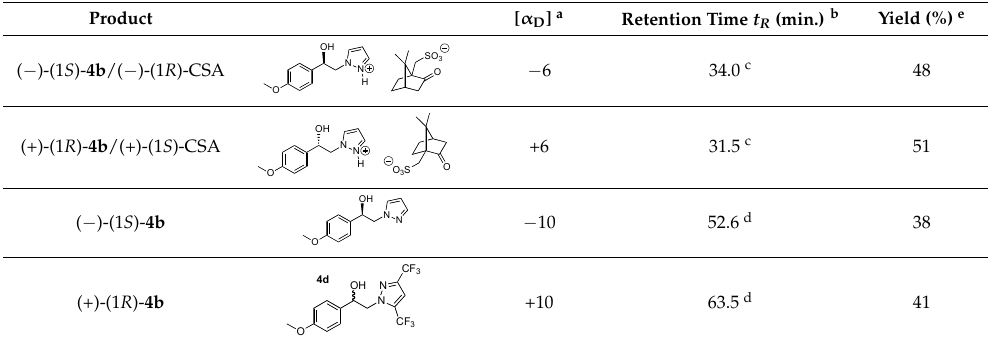
For this structure-activity relationship (SAR) study, we were also interested to evaluate the potential impact of chirality’s of the compounds 7 on SOC channels activities because our present protocol for preparation of these pyrazole SKF-96365 analogues produced a (±) racemic mixture. Based on this finding, our attention was attracted by the method of half-quantities [28] for resolution of our (±)-(1 R , 1 S )-1-(4-methoxyphenyl)-2-(1 H -pyrazol-1-yl)ethan-1-ol 4b mixture (Scheme 2). To find a simple and cost effective resolution procedure for (1 R )- 4b and (1 S )- 4b , we used commercial (+)-(1 S )- and ( − )-(1 R )-10-camphorsulfonic acid (CSA). Treatment of (±)-(1 R , 1 S )-1-(4-methoxyphenyl)-2-(1 H -pyrazol-1-yl)ethan-1-ol 4b with 0.5 equivalent of ( − )-(1 R )-CSA in dry acetone caused the formation of a fine suspension for the first fraction of diastereomer ( − )-(1 S )- 4b /( − )-(1 R )-CSA (>85% de), which was recrystallized in dry acetone (52% isolated yield, >97% de). Then, a solution of this salt [( − )-(1 S )- 4b /( − )-(1 R )-CSA] in dry acetone was submitted to diasteromeric enrichment by addition of 0.02 equivalent of (±) racemic 4b . After work-up the pure